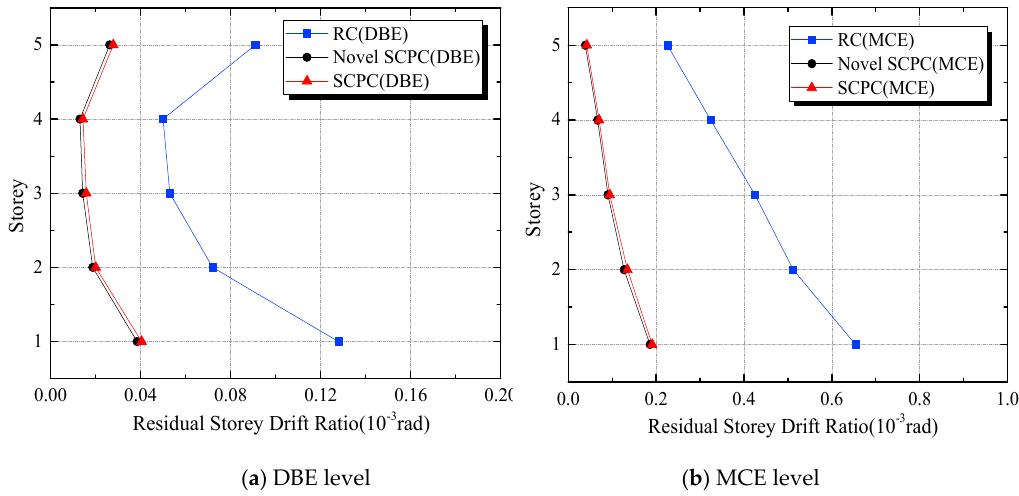
Figure 25. Maximum residual inter-story drift ratios of three frames at DBE and MCE level.